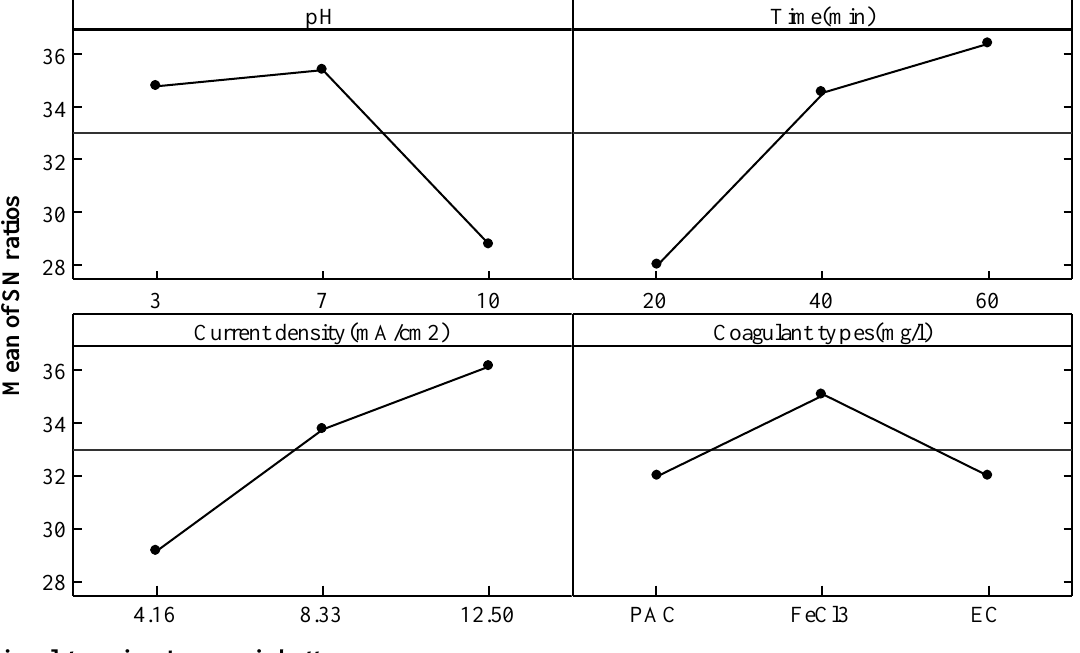
Main Effects Plot (data means) for SN ratios